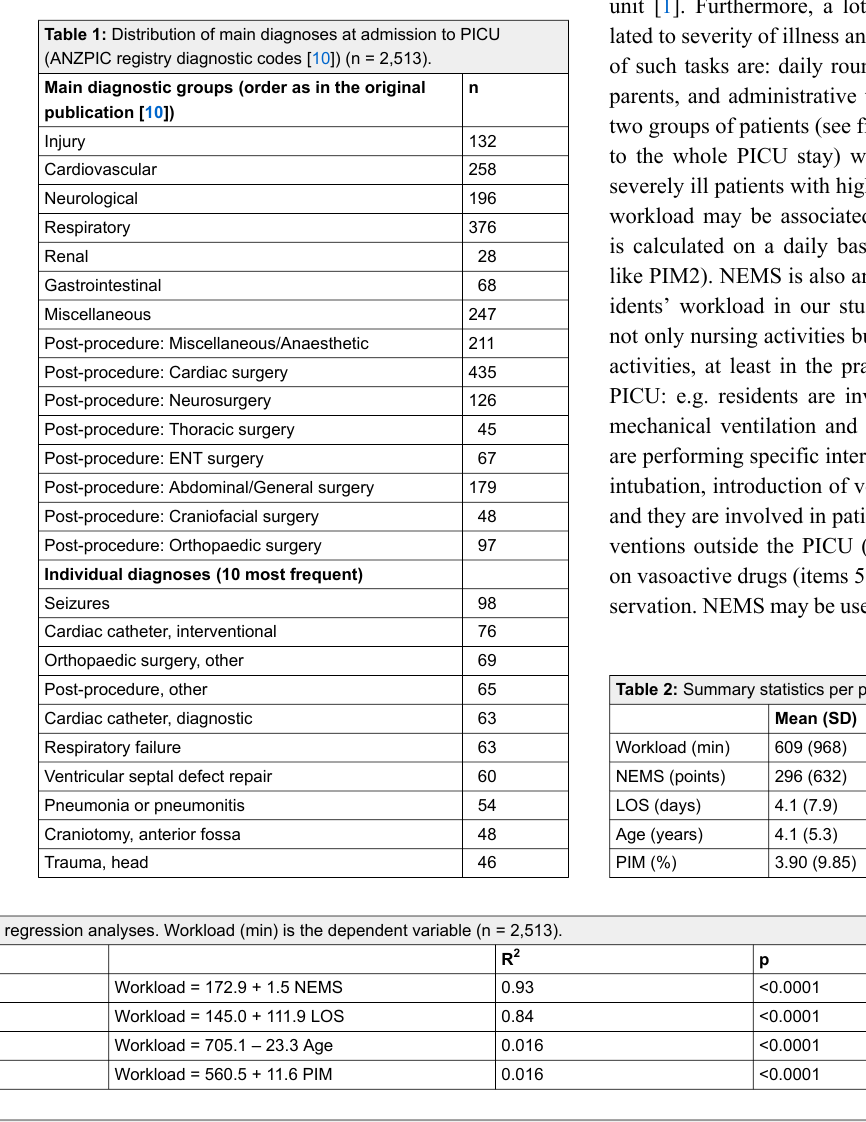
Table 1: Distribution of main diagnoses at admission to PICU (ANZPIC registry diagnostic codes [10]) (n = 2,513). Main diagnostic groups (order as in the original publication [10])